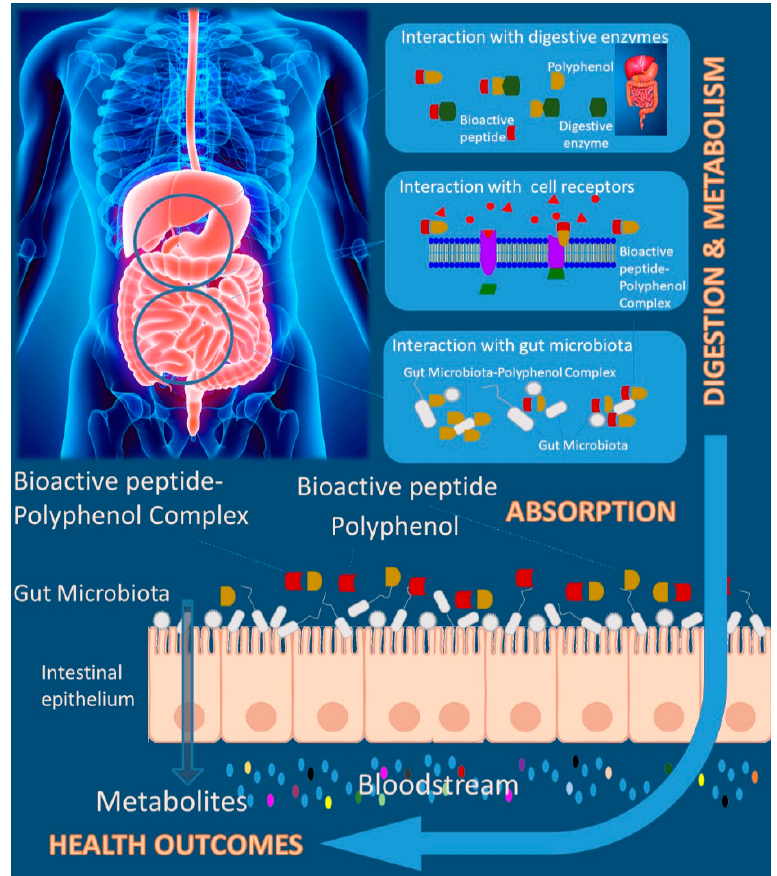
Figure 3. Polyphenol-bioactive peptide interaction and health-related effects.